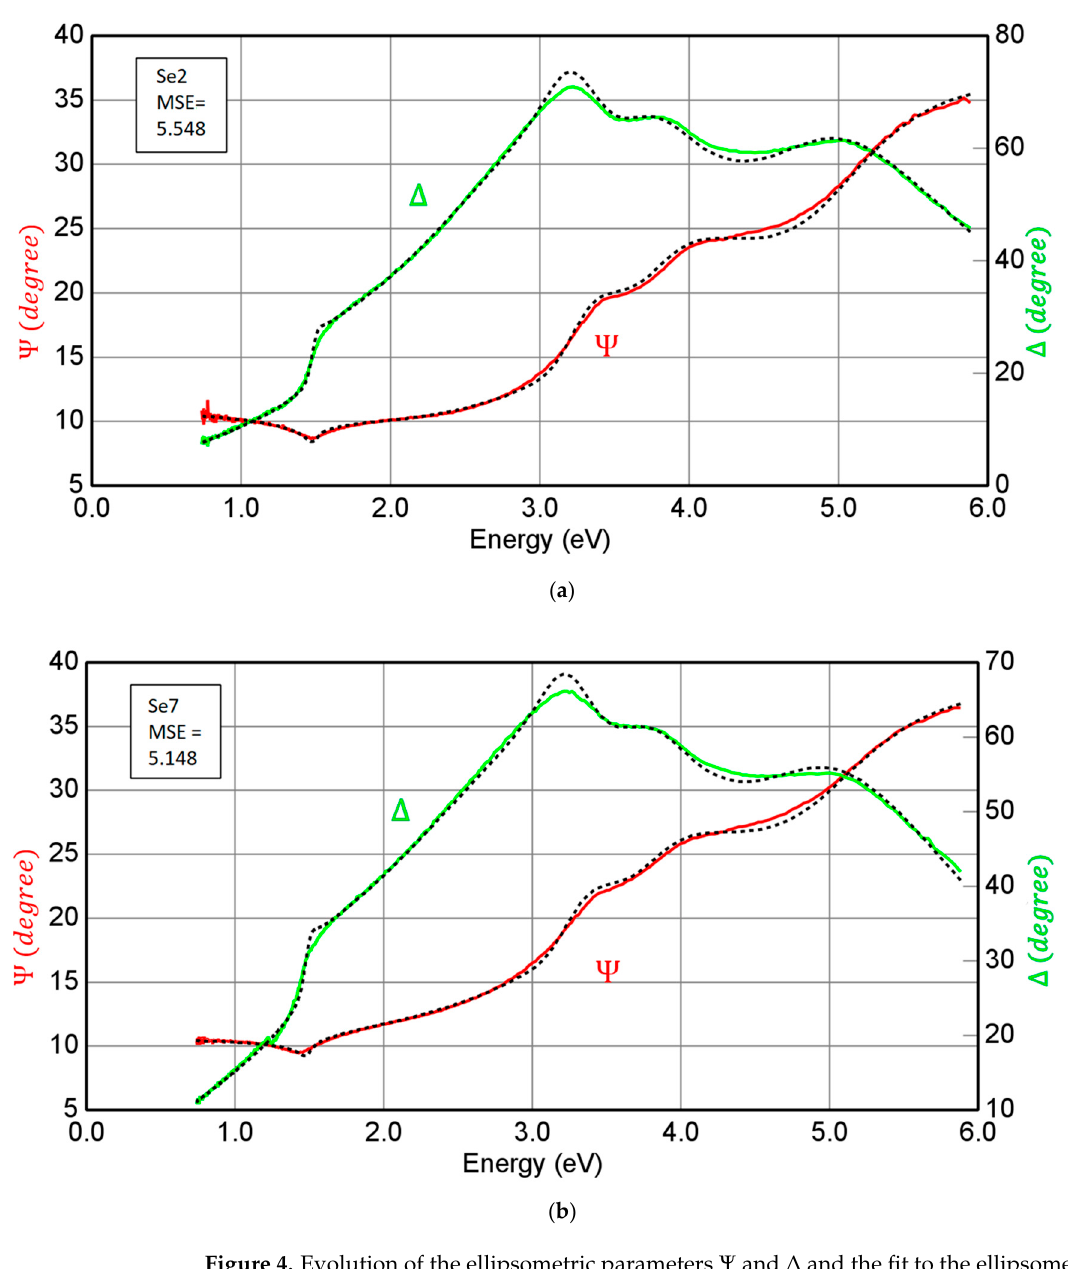
Figure 4. Evolution of the ellipsometric parameters Ψ and ∆ and the fit to the ellipsometry model 2 proposed in Figure 1b for different selenium compositions ( a ) Se2 and ( b ) Se7. The lines represented by different colours are the experimental data, and the dashed lines correspond to the model. Table 3. The CdTe-ox parameter used in the Cauchy equations (see reference [17]).